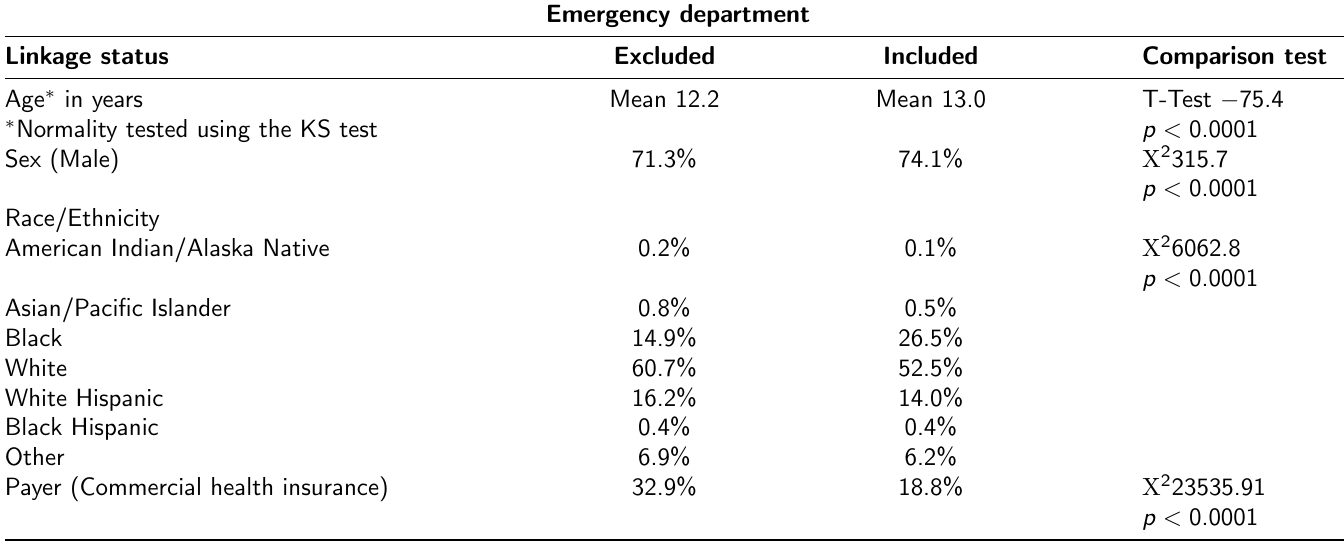
Table 5: Deterministic linkage statistics in the longitudinal sports and recreation injury study – differences in emergency department